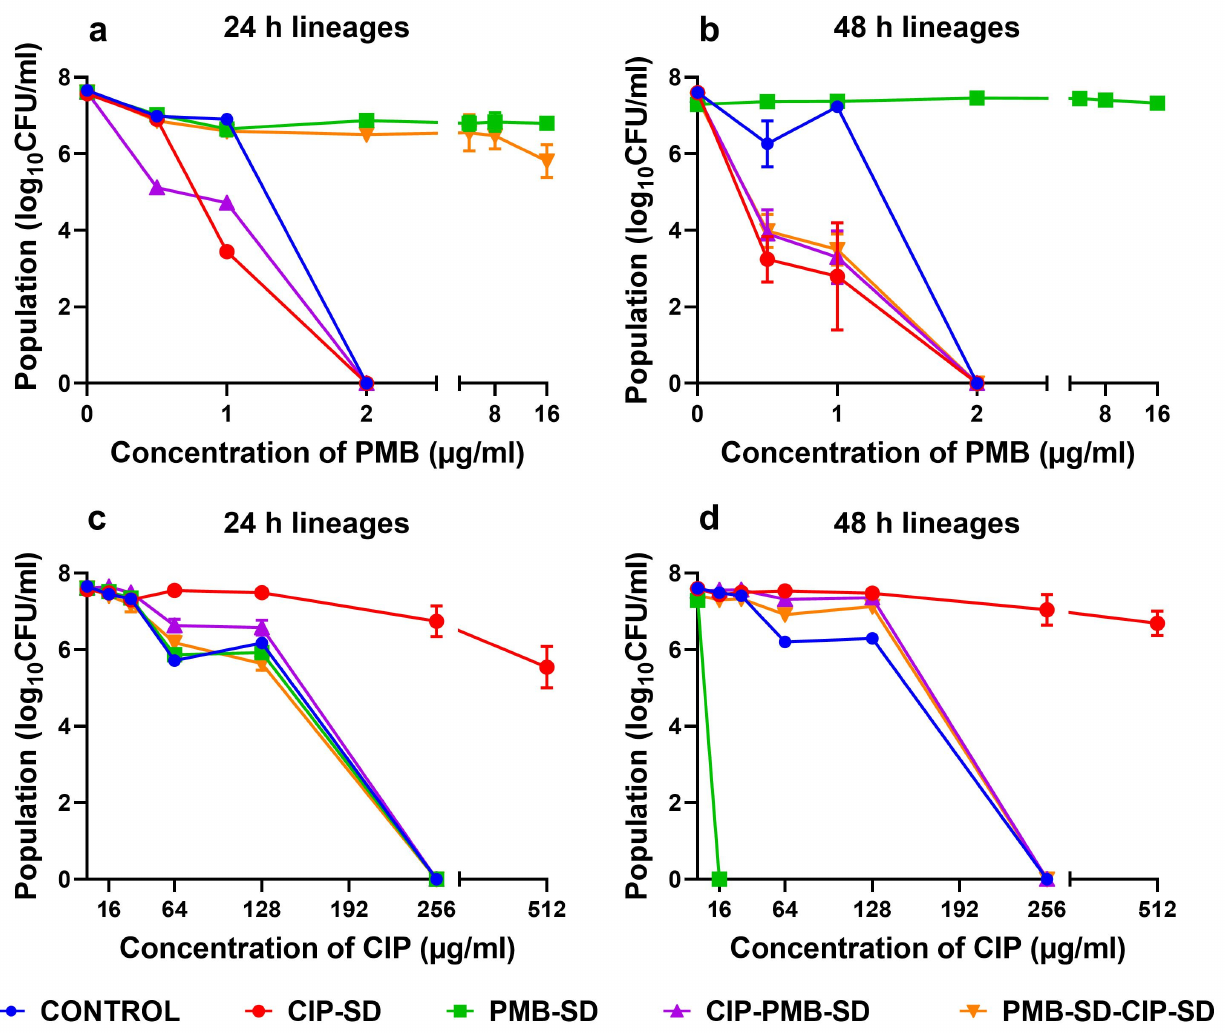
Figure 8. Population analysis profiles of lineages against PMB and CIP (mean ± SEM, n = 3). Lineages were treated with different antibiotics and have been coded by the names in the experimental design of the time–kill assay (Figure 1 and Table 3). ( a , c ) The results of lineages (after 24 h treatment in the time–kill assay) against different concentrations of PMB and CIP in the population analysis respectively; ( b , d ) the results of lineages (after 48 h treatment in the time–kill assay) against different concentrations of PMB and CIP in the population analyses, respectively.